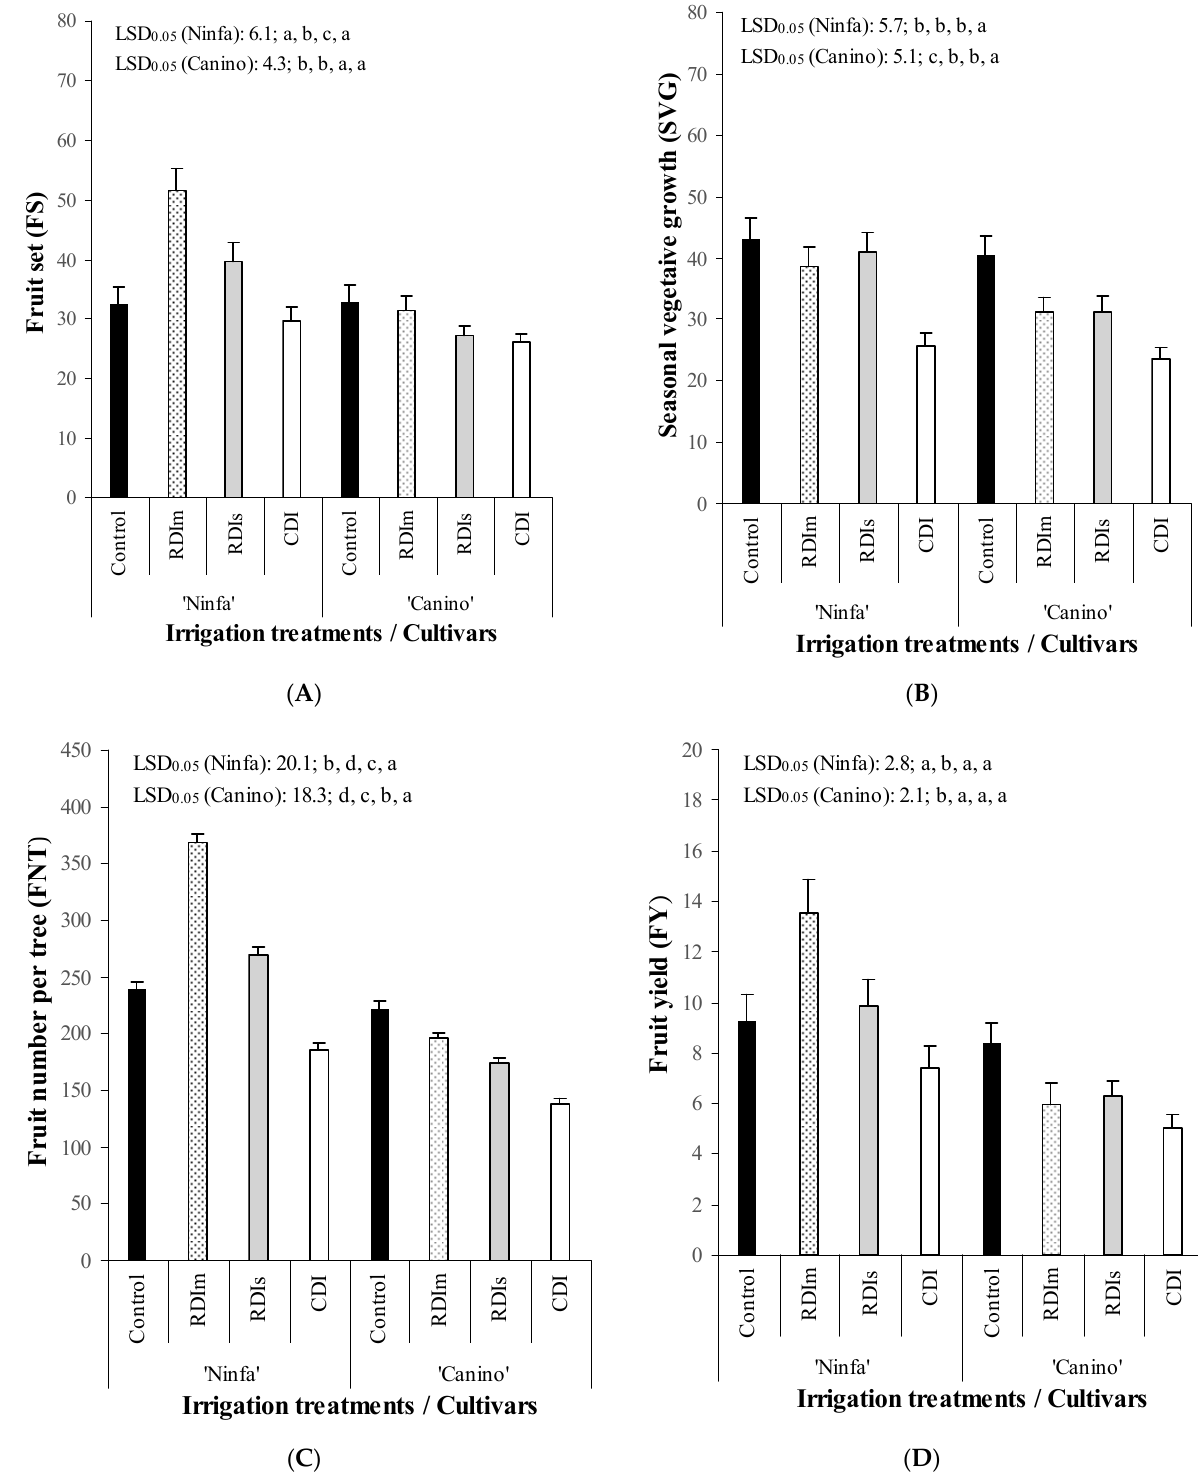
Figure 6. The effect of four irrigation treatments (control, moderate regular deficit irrigation—RDIm, severe regular deficit irrigation—RDIs and continuous deficit irrigation—CDI) and two cultivars (‘Ninfa’ and ‘Canino’) on four yield related measures. ( A ) fruit set—FS, ( B ) seasonal vegetative growth–SVG, ( C ) fruit number per tree—FN, and ( D ) fruit yield—FY. Data are means of 2016, 2017 and 2018. Explanation for standard deviation values, irrigation treatments, calculations of significant differences, and explanations for LSD 0.05 values are given in Figure 3.